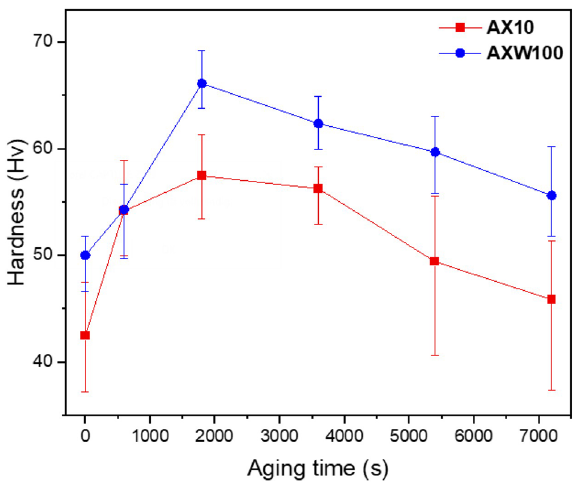
Figure 1. Hardness of the investigated AX10 and AXW100 alloy sheets according to the isothermal aging treatment at 250